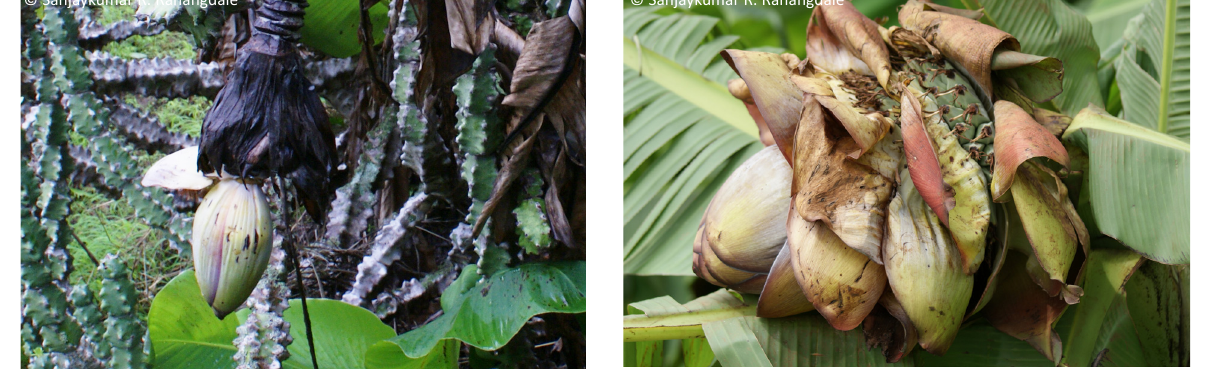
Image 2. Abortive flowering and fruiting of Ensete superbum at harvesting site